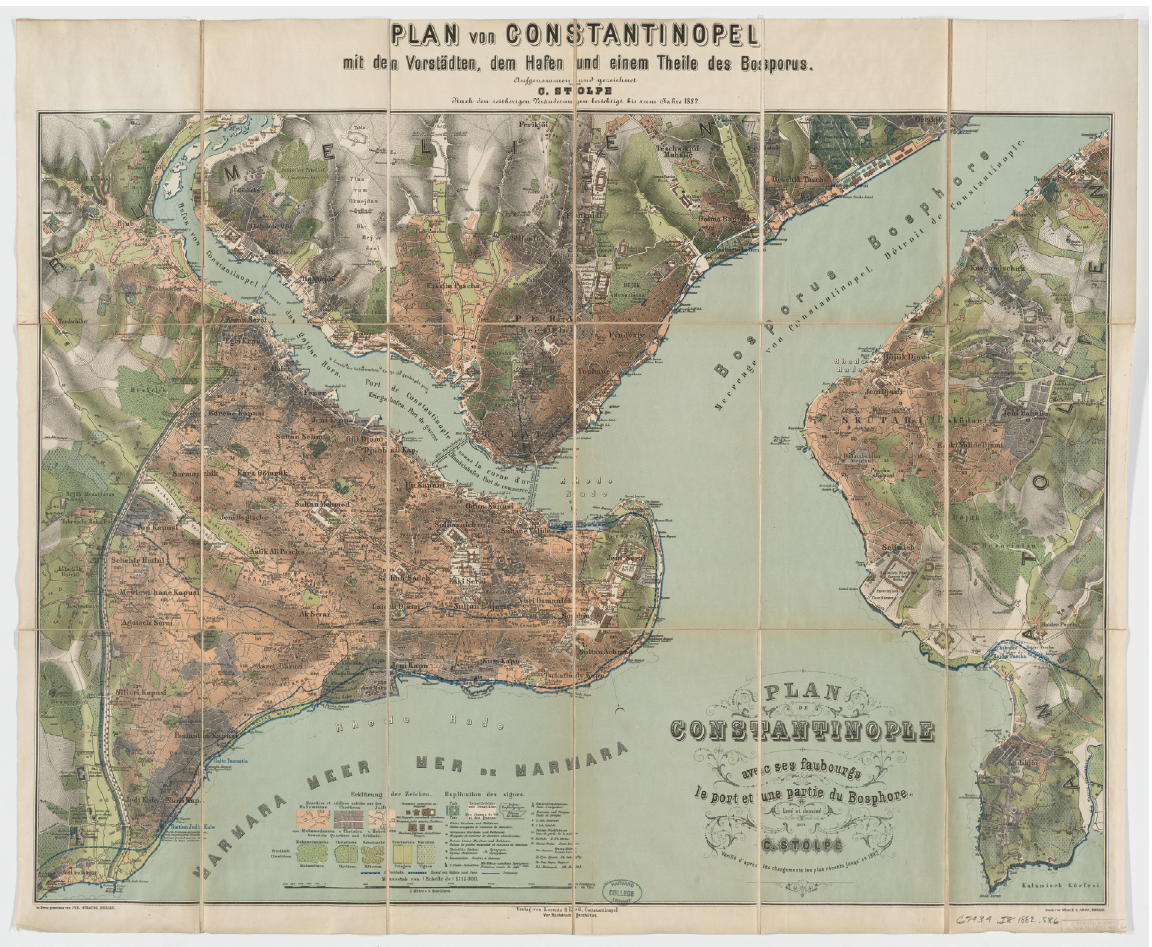
Old port of Constantinople and the surrounding faubourgs during the nineteenth century, by German cartographer C. Stolpe, dating 1880, ©Harvard Library